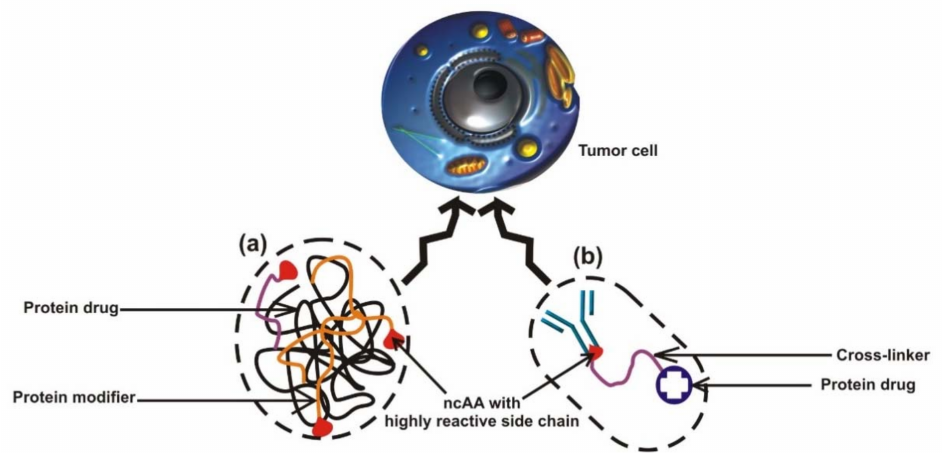
Figure 4. Modifications of protein-based drugs to target tumor cells. ( a ) The application of protein or chemo drug in tumor therapy using ncAA-mediated chemical alteration to improve the pharma- cokinetic properties of the drugs to targeted tumor cells. A protein modifier (orange thread) can be used for the controlled drug delivery of a protein drug (black woven thread), thereby enhancing the drug action against tumor cell. All red droplets represent ncAA with a highly reactive side chain. ( b ) Schematic representation of bioconjugate used for the selective delivery of a drug of interest to cancerous cells using a drug–ncAA–antibody complex. The protein drug is conjugated to the reactive side chain of the ncAA by a